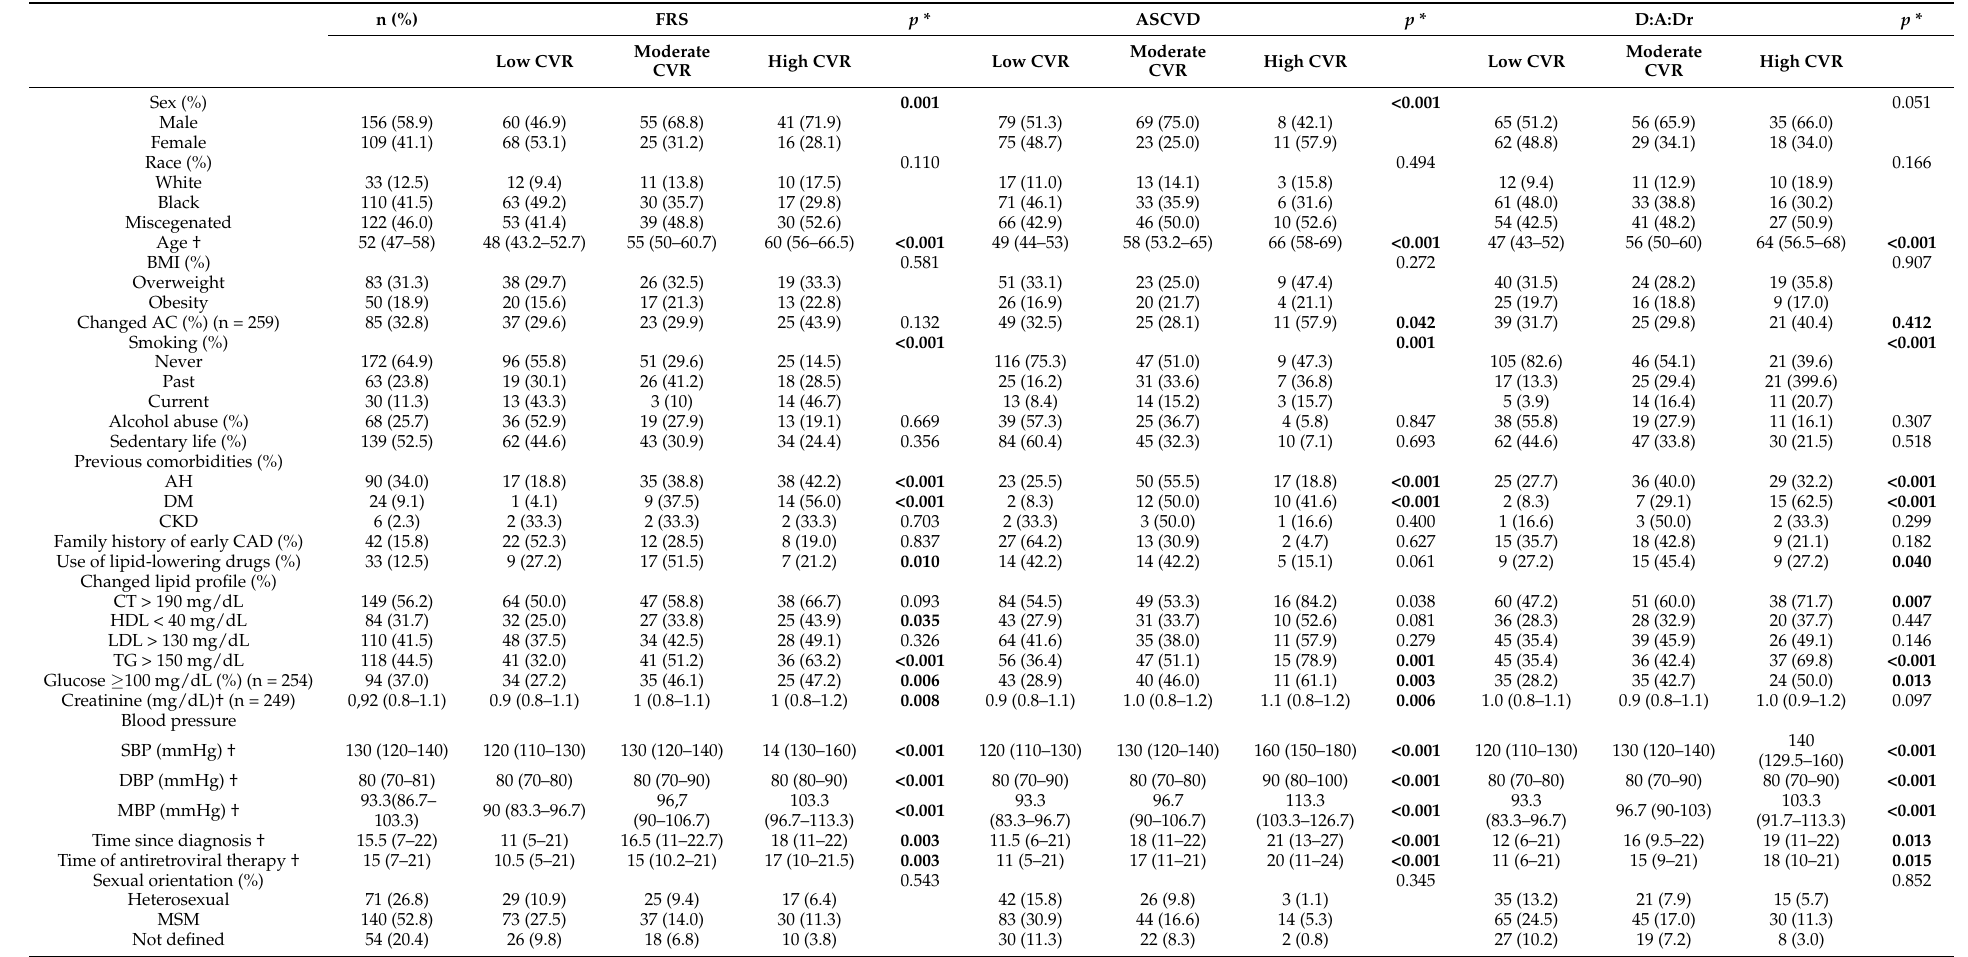
Table 2. Demographic, clinical and laboratory characteristics of the study population according to the CVR stratification